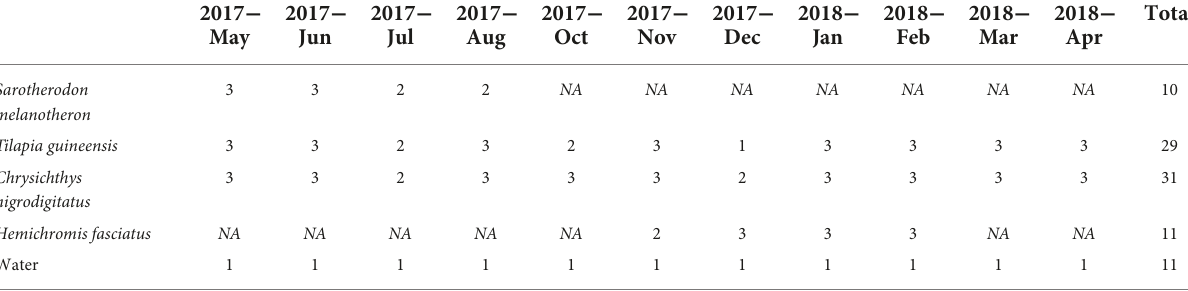
TABLE 1 Water and fish samples collected monthly in the Aghien lagoon over a